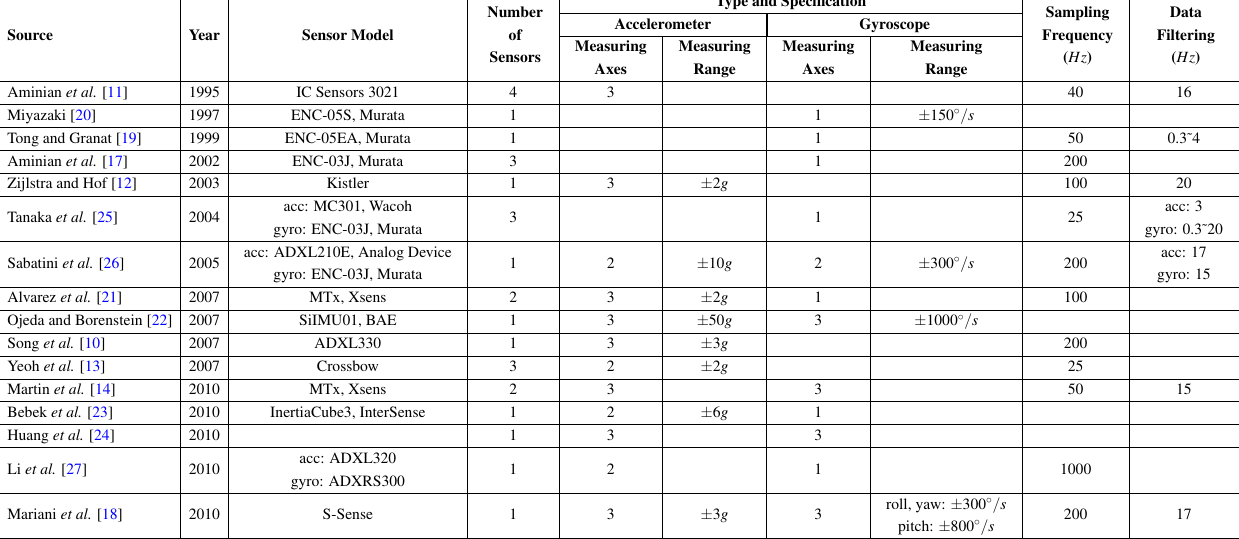
Table 1. Inertial Sensor Specifications in Reviewed